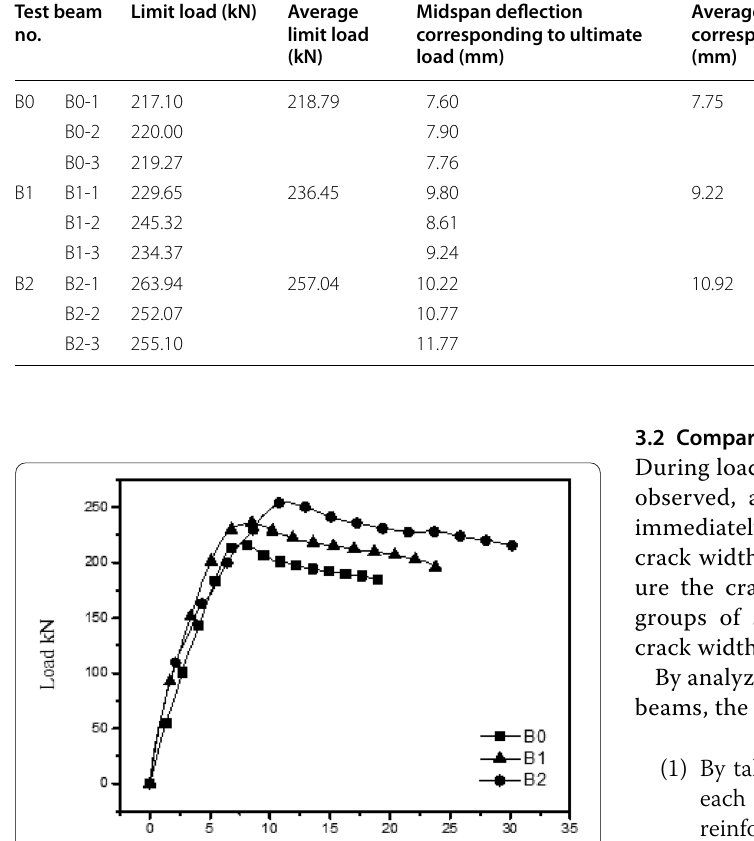
Table 4 Ultimate load of test beam and corresponding midspan deflection. Test beam no.